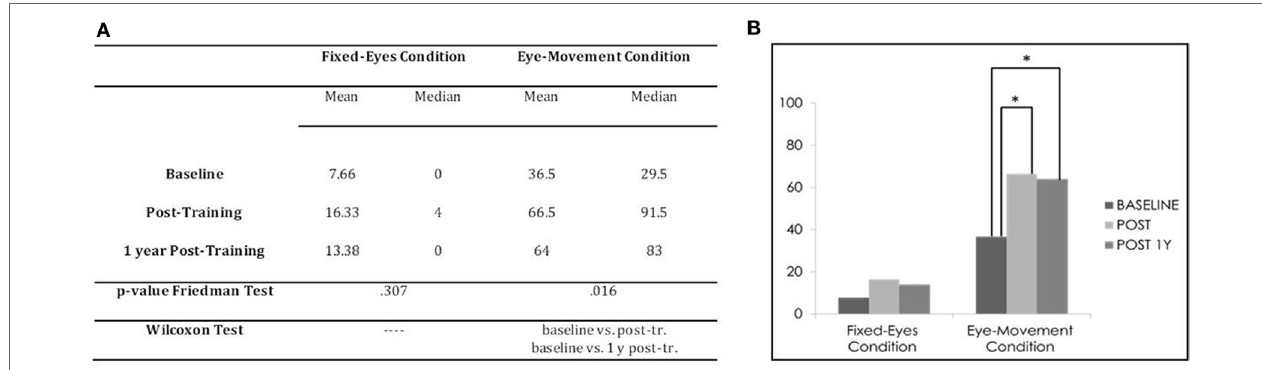
FIgUre 5 | Subject 2: unimodal visual test. (A) Mean and median percentages of visual detections (hemianopic hemifield) in the different evaluations, p -value of the Friedman Tests and results of Wilcoxon Tests. (B) Graphical Representation: mean percentages of visual detections ( y -axis) at baseline vs. post-training vs. 1 year post-training ( x